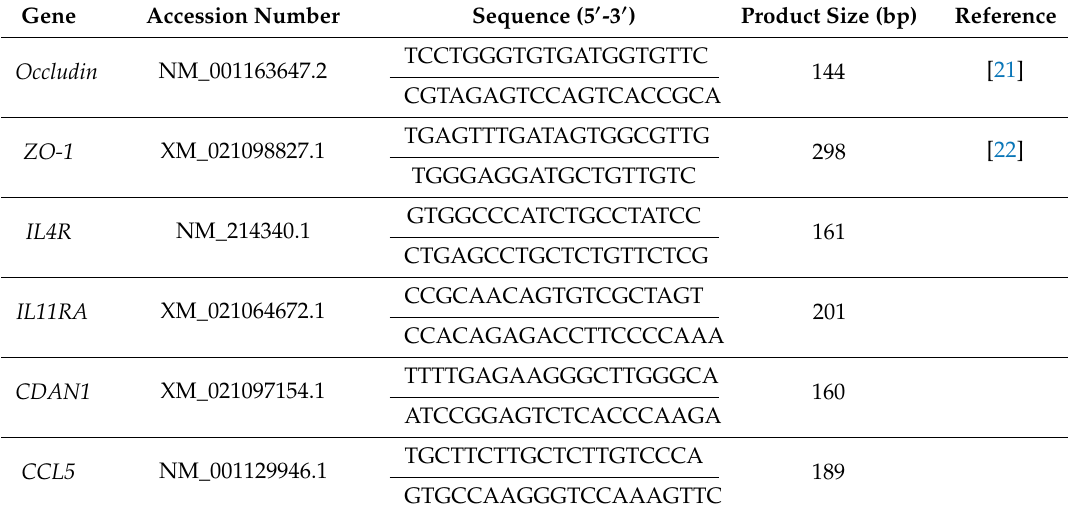
Table 1. Primers used for real-time quantitative PCR